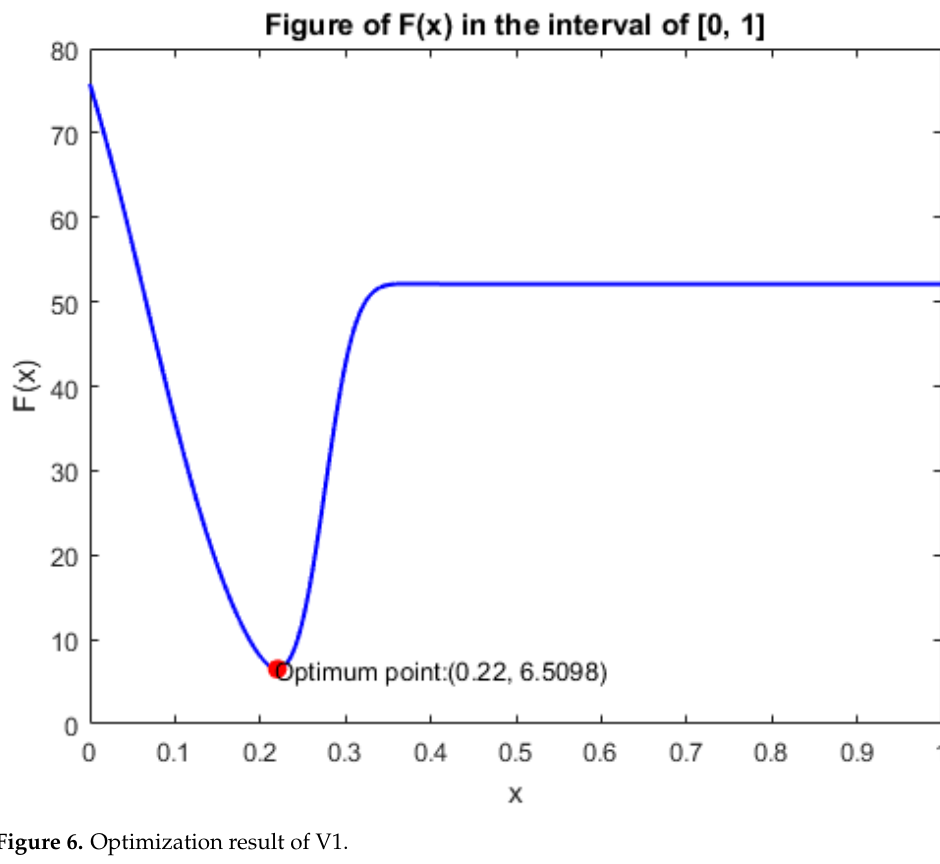
Figure 6. Optimization result of V1.